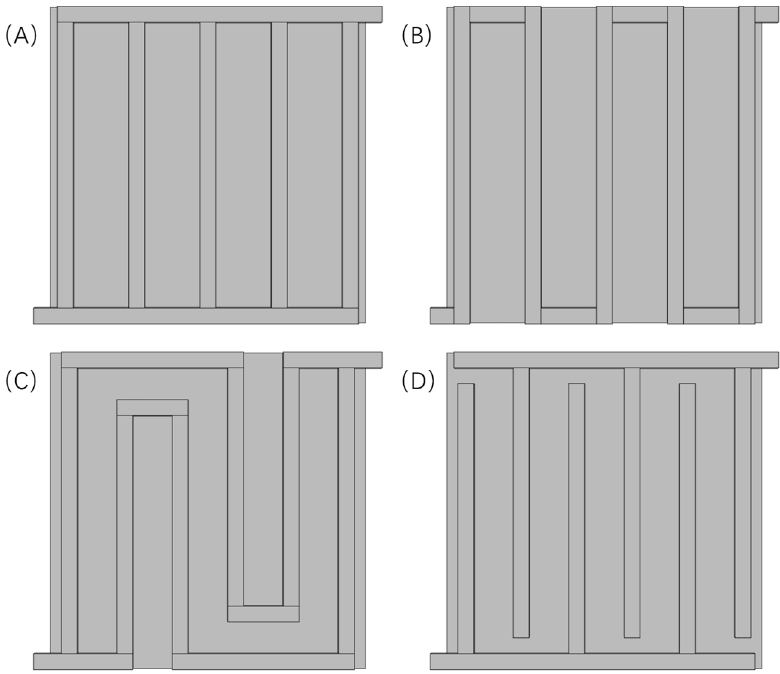
Figure 3. The different flow fields of PEMEC. ( A ) Parallel, ( B ) serpentine, ( C ) multi-serpentine, and ( D ) interdigitate.